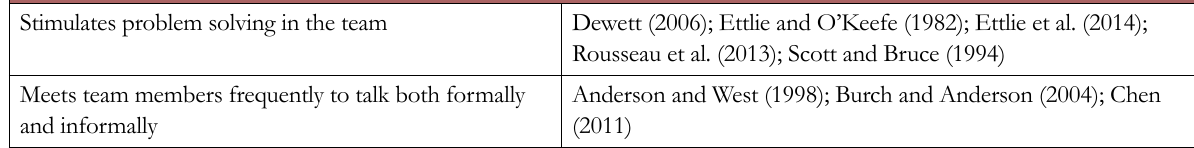
Table 18. Behaviours showing “working well with others”